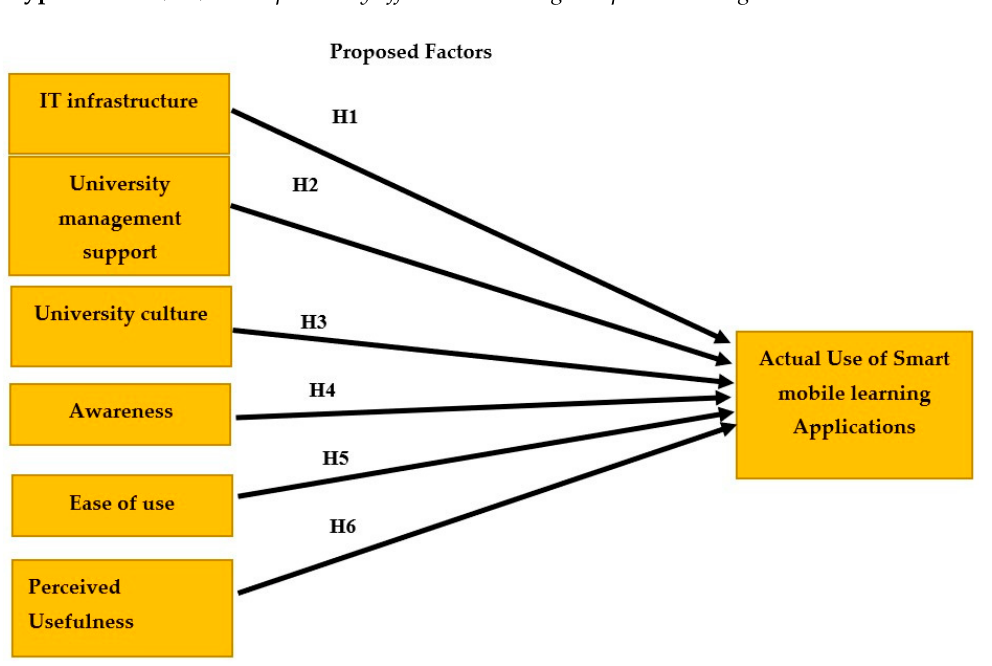
Figure 2. The proposed model for explaining the acceptance of an M-learning system.